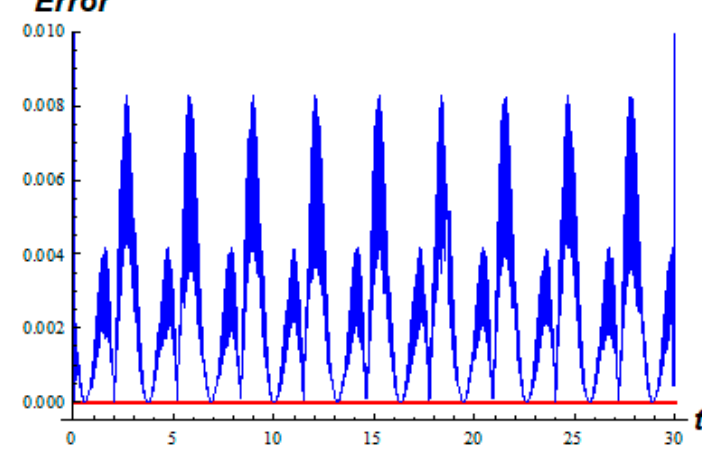
Figure 4. The absolute errors corresponding to approximate solutions using the MDM (red solid line) and RK4 method (blue line) for 0 ≤ t ≤ 30 and step-size h = 0.1.